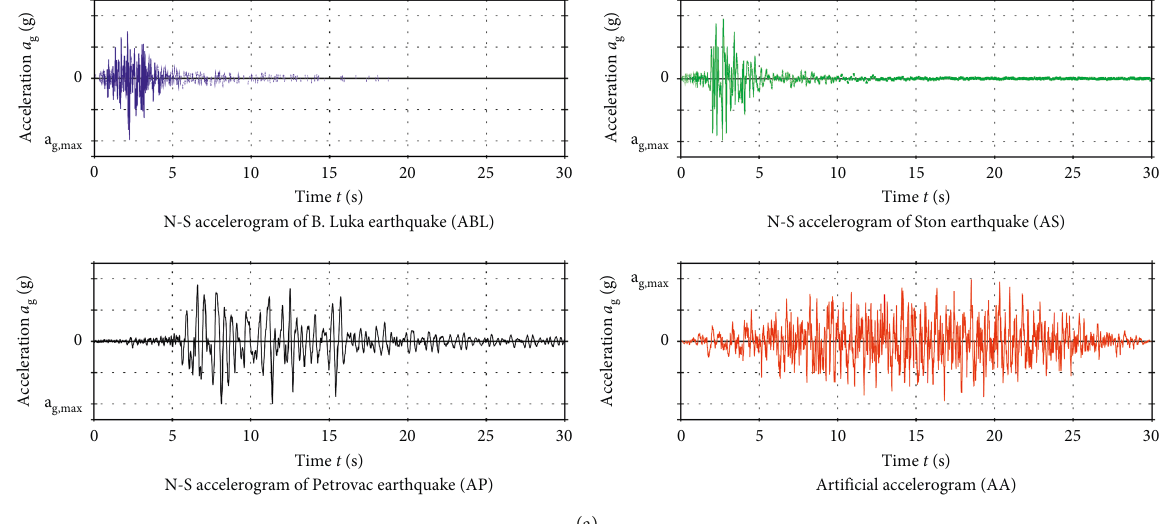
N-S accelerogram of Petrovac earthquake (AP)